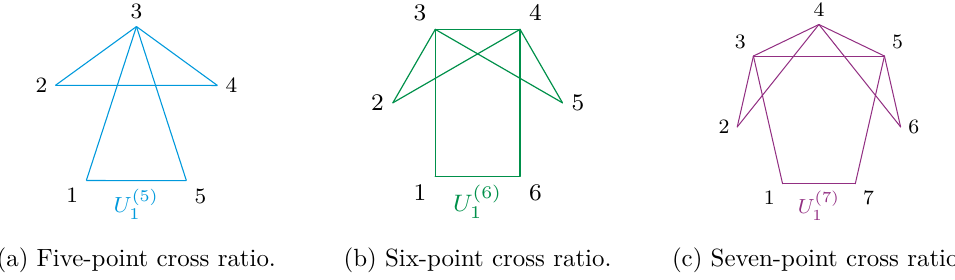
Figure 3 : Polynomial cross ratios for five, six, and seven point functions. The colored lines correspond to scalar products present in the expression of the cross ratio, with lines that intersect outside vertices corresponding to terms in the